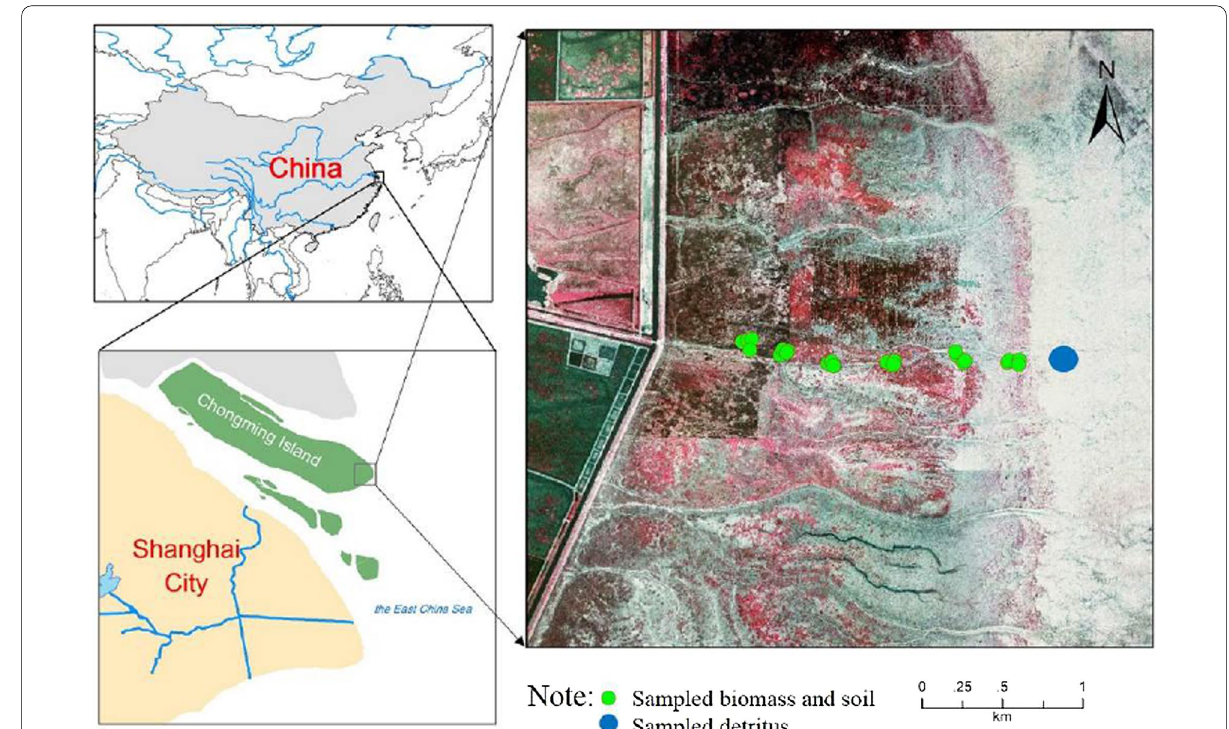
Fig. 1 Locations of the sampled ecosystems in Dongtan, Chongming Island, the Yangtze Estuary, China. The detritus field measurement platform was located at 31°31’N and 121°59’E at the mouth of a large creek in this